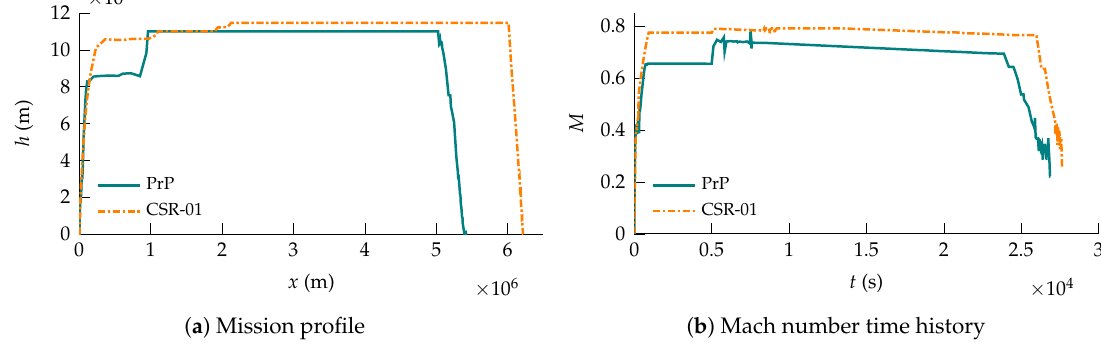
Figure 10. Harmonic mission performance comparison between the PrP and CSR-01. Table 6. The harmonic range performance of the PrP w.r.t. the